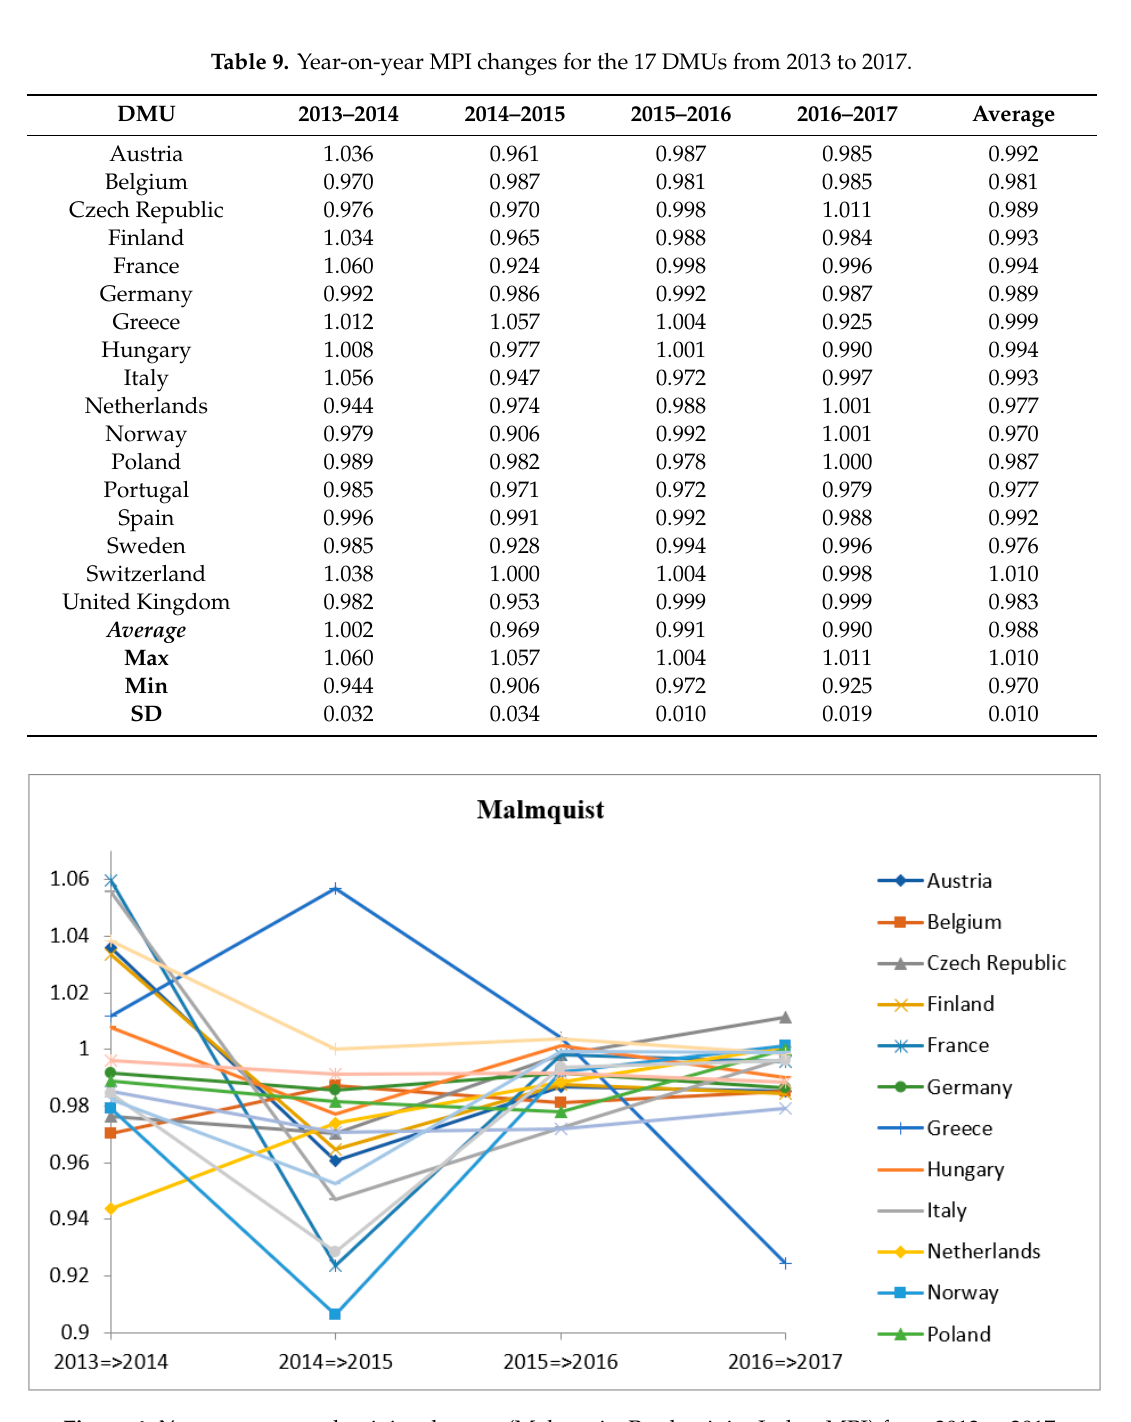
Figure 4. Year-on-year productivity changes (Malmquist Productivity Index–MPI) from 2013 to 2017.